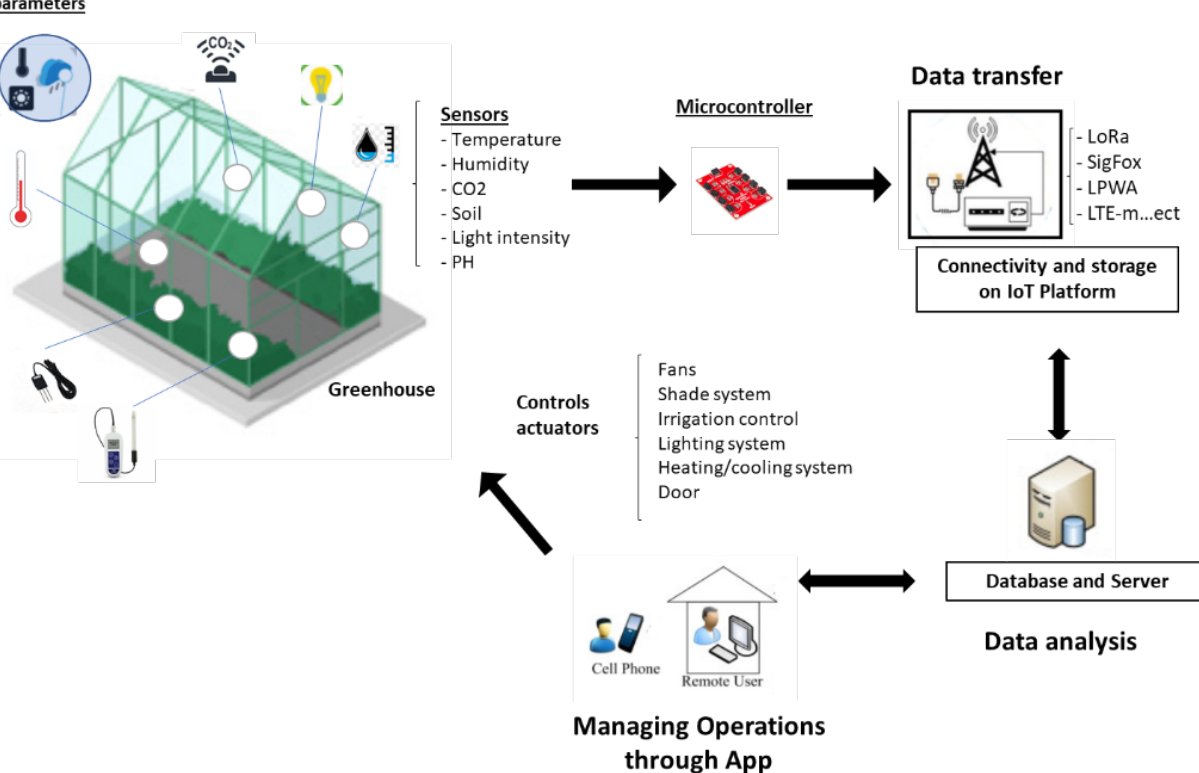
Figure 1. IOT General architecture for greenhouse Figure 1 . IOT General architecture for greenhouse applications .